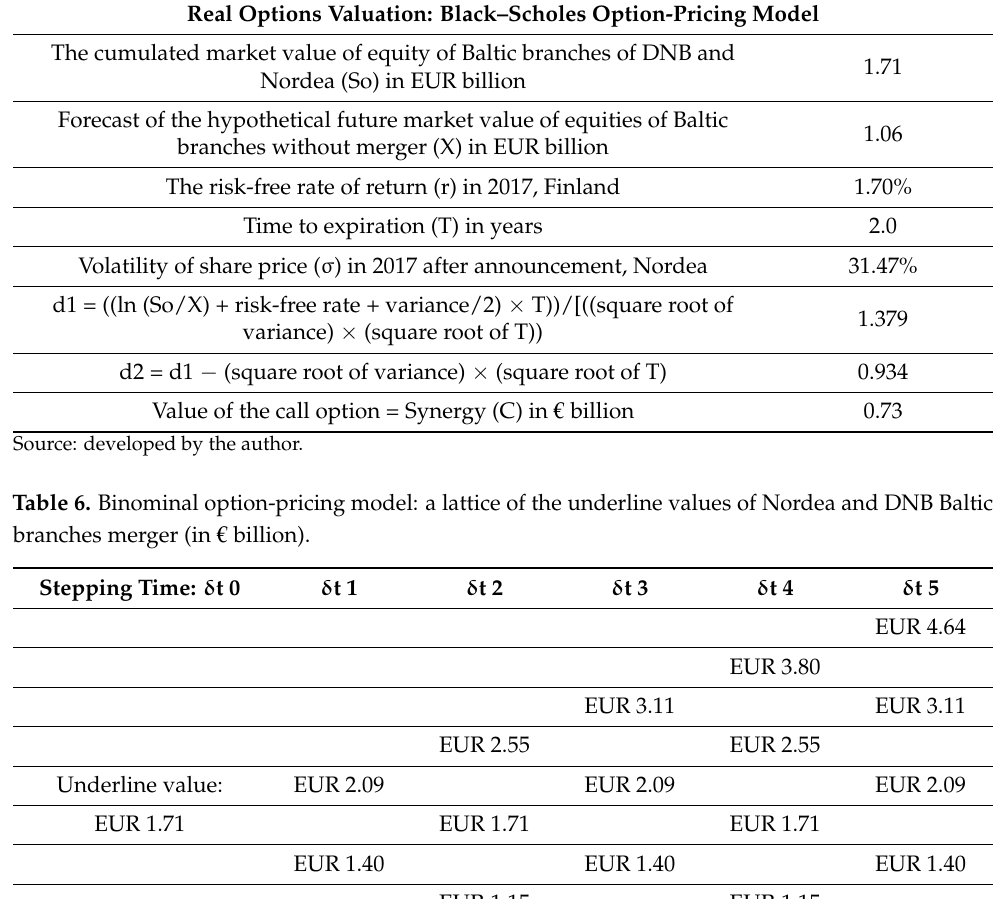
Table 5. Black–Scholes option-pricing model’s variables and results. Real Options Valuation: Black–Scholes Option-Pricing Model The cumulated market value of equity of Baltic branches of DNB and Nordea (So) in EUR billion Forecast of the hypothetical future market value of equities of Baltic branches without merger (X) in EUR billion The risk-free rate of return (r) in 2017, Finland